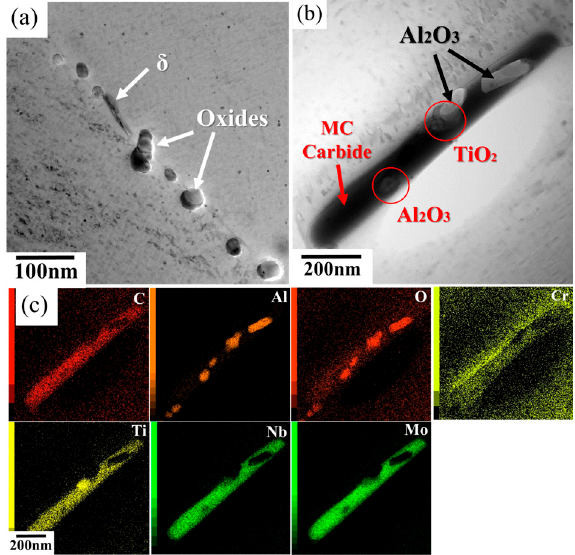
Figure 7. TEM bright field micrographs of ( a ) particles along the PPB; ( b ) growth behavior of oxy-carbides; ( c ) EDS digital maps showing the distribution of elements within the HIPed material after the heat-treatment process. Metals 2017 , 7 , 367